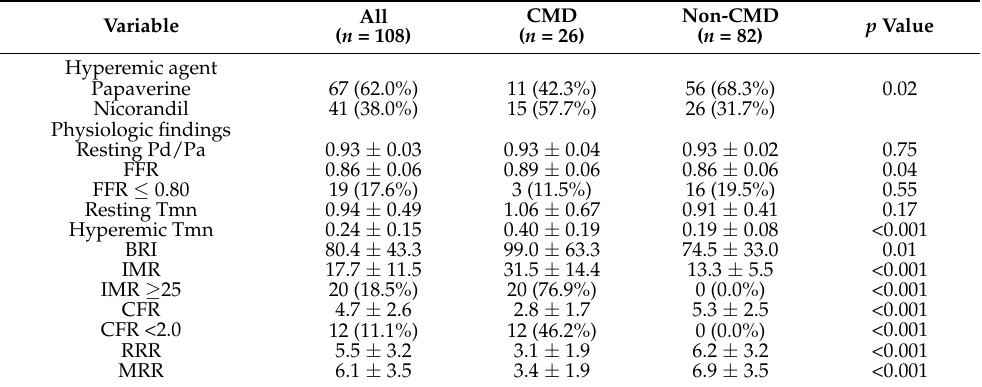
Table 2. Physiological